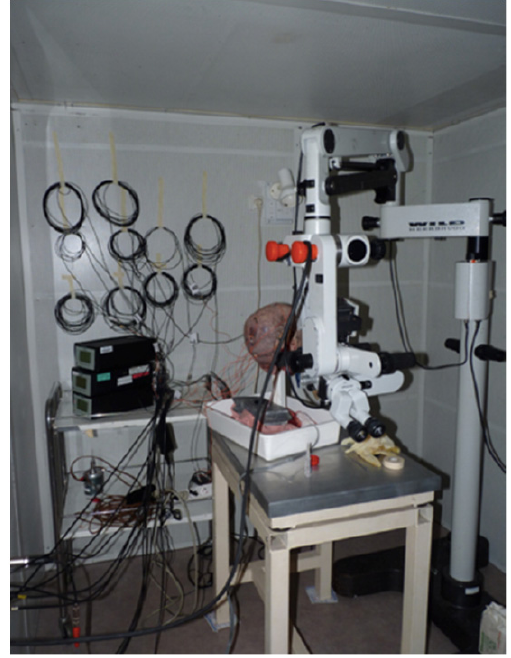
Figure 3. Experiment set-up in the anechoic chamber. The laser velocimeter (Laser Doppler Vibrometer OFV 534-Polytec, Hudson, MA, USA) was oriented so as to send a signal directly on the reflector on the round window on one side. The laser, accelerometers, and BAHA™ implants interfaced with an automatic Ultrasonic Pulse Velocity (UPV) 8-channels audio analyzer (Rohde-Schwarz, Attle-